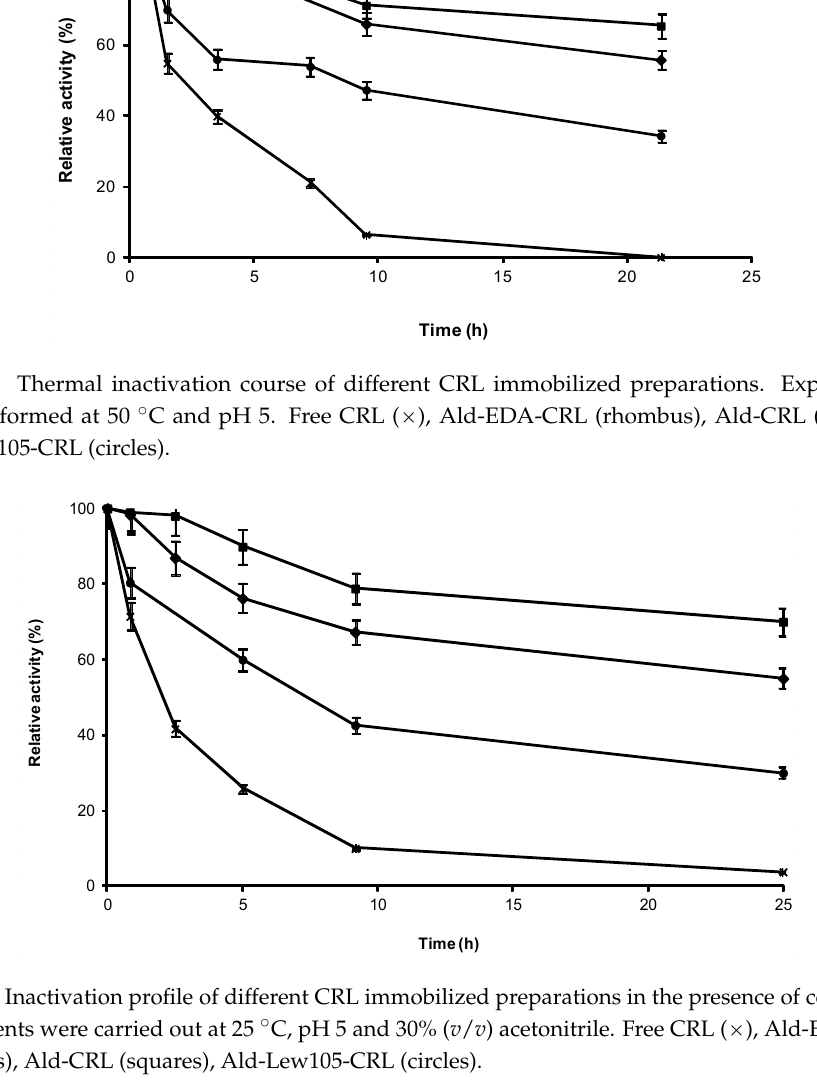
Figure 5. Thermal inactivation course of different CRL immobilized preparations. Experiments were performed at 50 °C and pH 5. Free CRL (×), Ald ‐ EDA ‐ CRL (rhombus), Ald ‐ CRL (squares), Ald ‐ Lew105 ‐ CRL (circles).